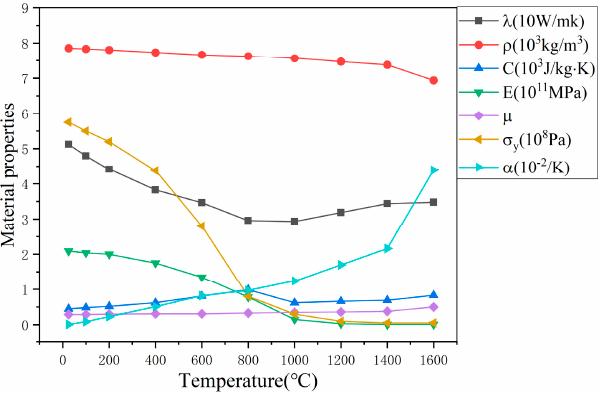
Figure 10. Three-dimensional model. Figure 11. The temperature-dependent thermal-physical material properties of 07MnNiCrMoV, data from [23].